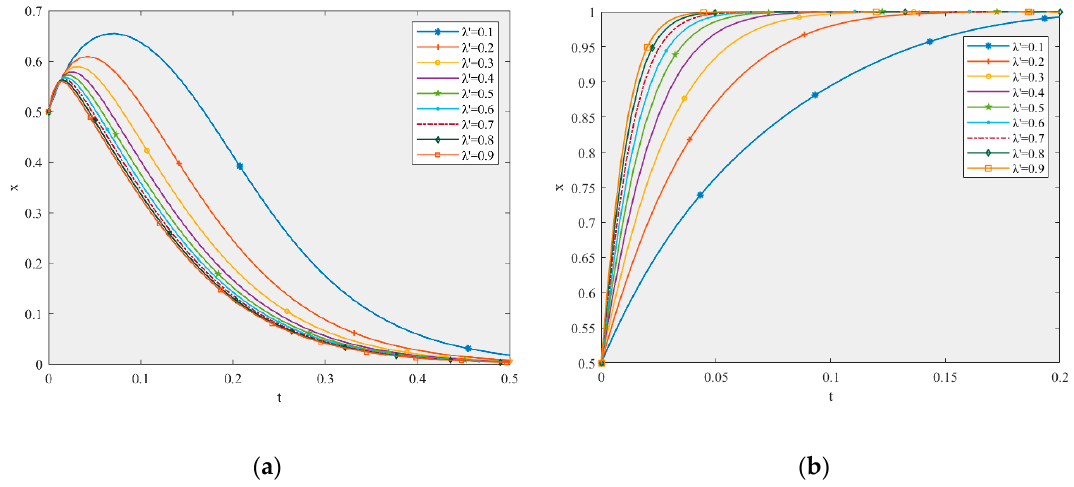
Figure 5. The effect of λ ’ ( a ) on the production unit and ( b ) the recycling unit in the game equilibrium.